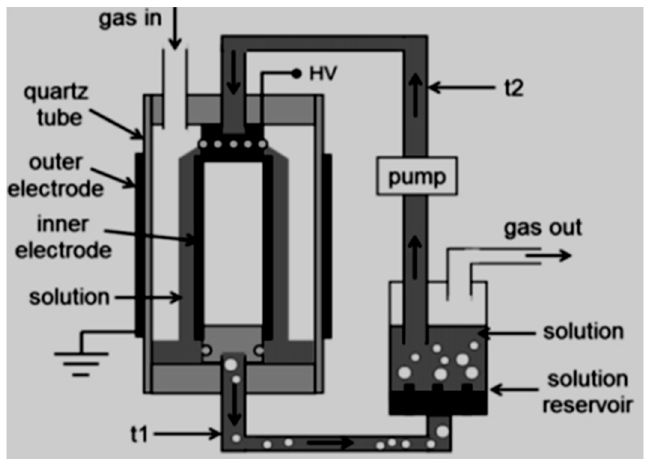
Figure 2. Single dielectric barrier discharge (DBD) reactor used for the decomposition of pentoxi- fylline and antibiotics in water [155].